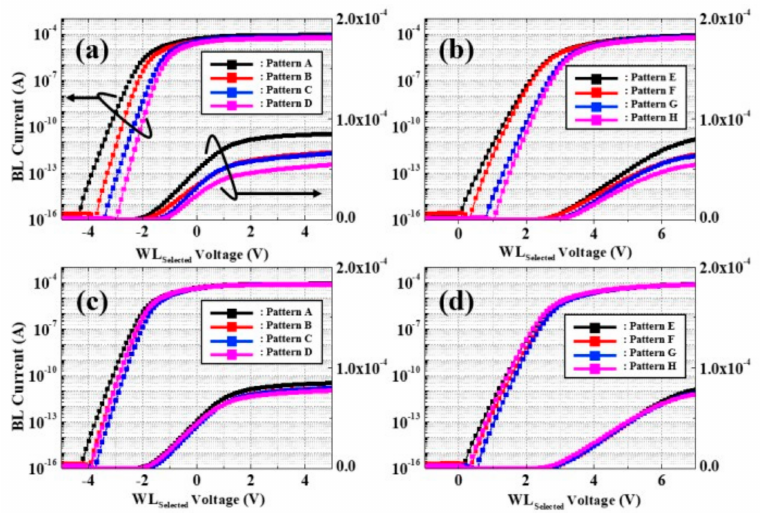
Figure 8. Simulation result of the selected cell I-V curve characteristic of each pattern through the conventional read scheme at the space length of 10 nm 3D NAND flash memory string: ( a ) patterns A, B, C, and D, ( b ) patterns E, F, G, and H, proposed using optimized 1.5 V of ∆ V string, ( c ) patterns A, B, C, and D, ( d ) patterns E, F, G, and